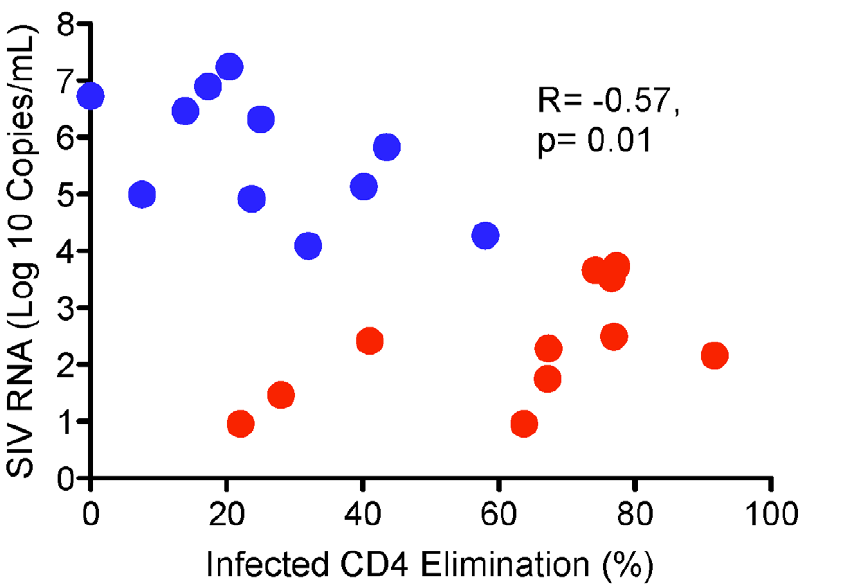
Figure 3. Infected CD4 Elimination (ICE) inversely correlates with plasma SIV RNA levels in SIV-infected rhesus macaques. Red dots represent LTNP/EC (n=11). Blue dots represent progressors (n=11). Statistical analysis was performed by the Spearman rank method.